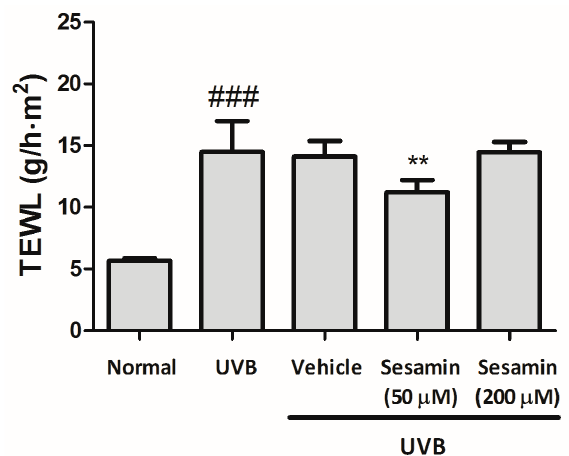
Figure 14. Effect of sesamin on the transepidermal water loss (TEWL) in chronic UVB-irradiation hairless mice at the 10th week. Significant difference versus normal group: ### p < 0.001. Significant difference versus UVB group: ** p < 0.01.